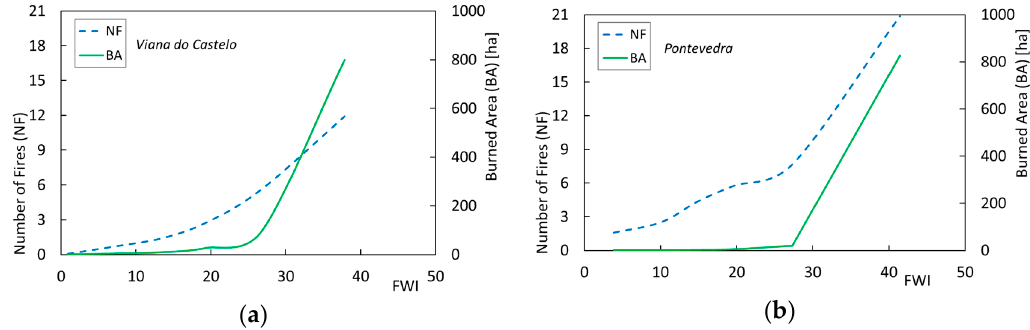
Figure 4. Average number of daily fires (NF) and burned area (BA) as a function of FWI for: ( a ) Portuguese district of Viana do Castelo; and ( b ) the Spanish province of Pontevedra .